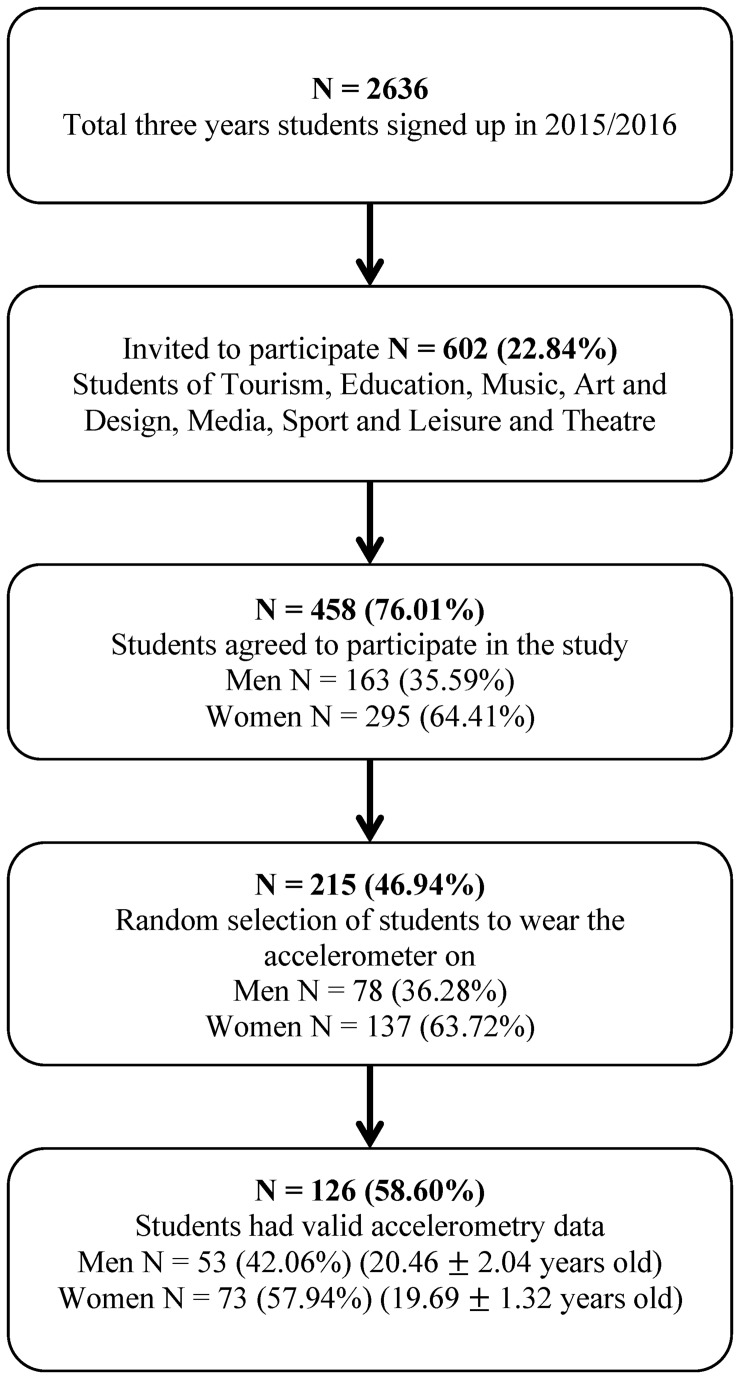
Flowchart showing the progress of students during the study.